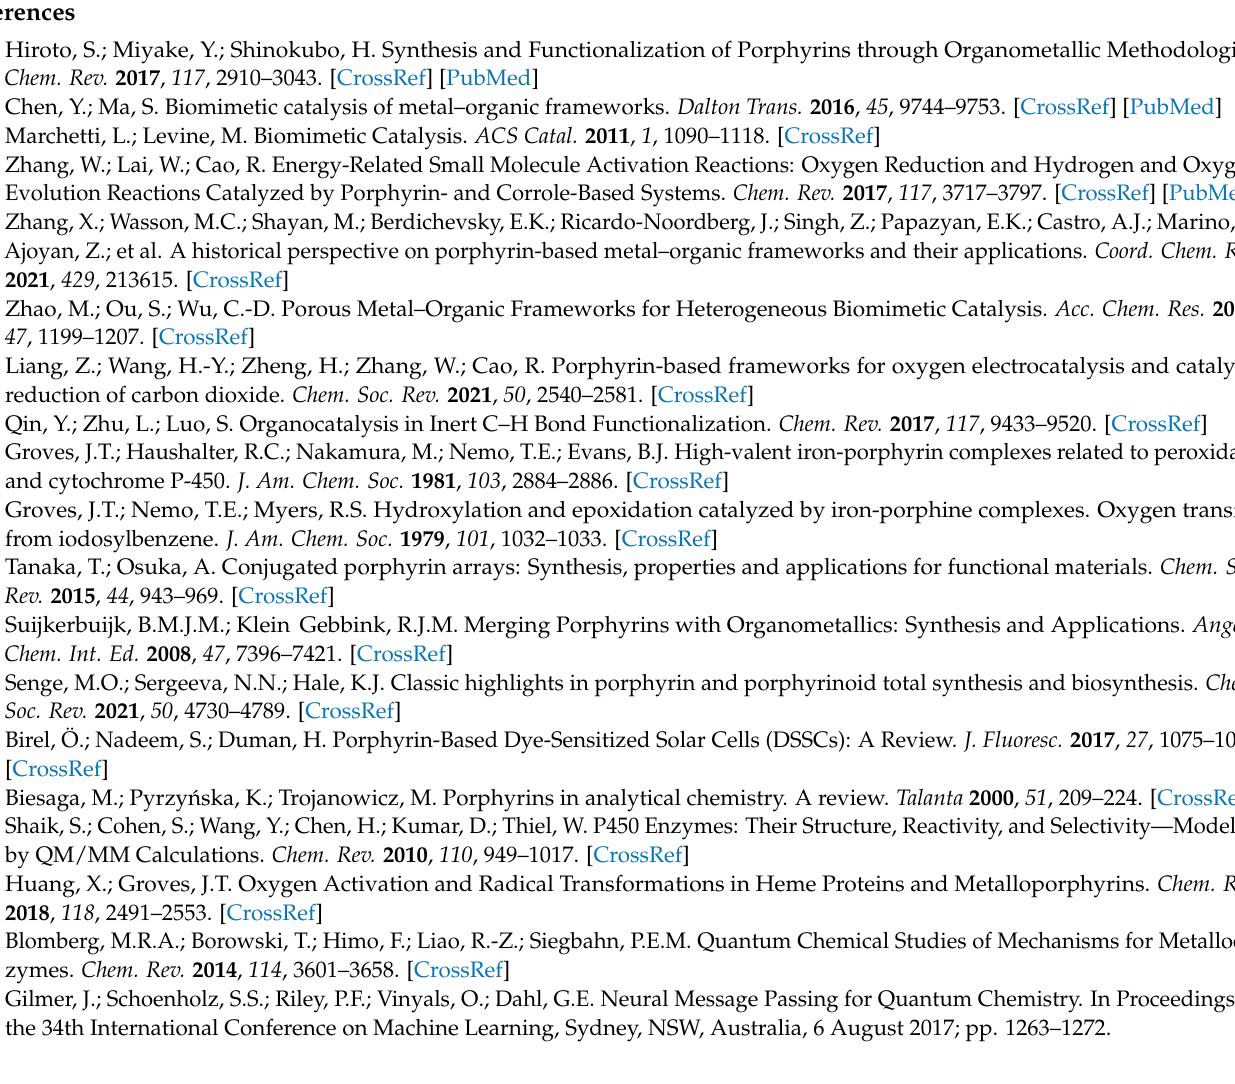
structure. Figure S4: Comparison of evaluation results of all model test sets. Figure S5: Comparison of results of ChemBERTa pre-trained